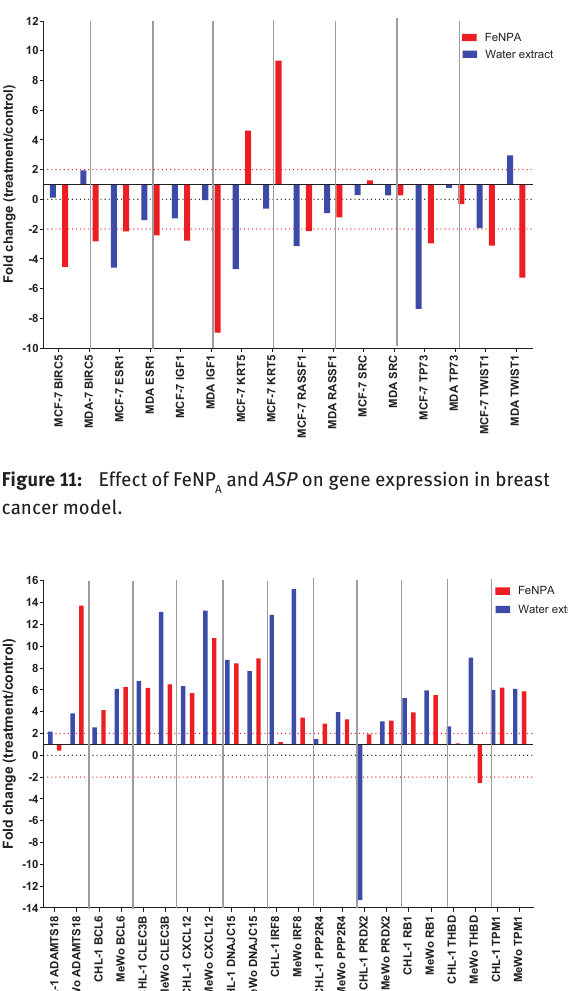
Figure 12: Effect of FeNP